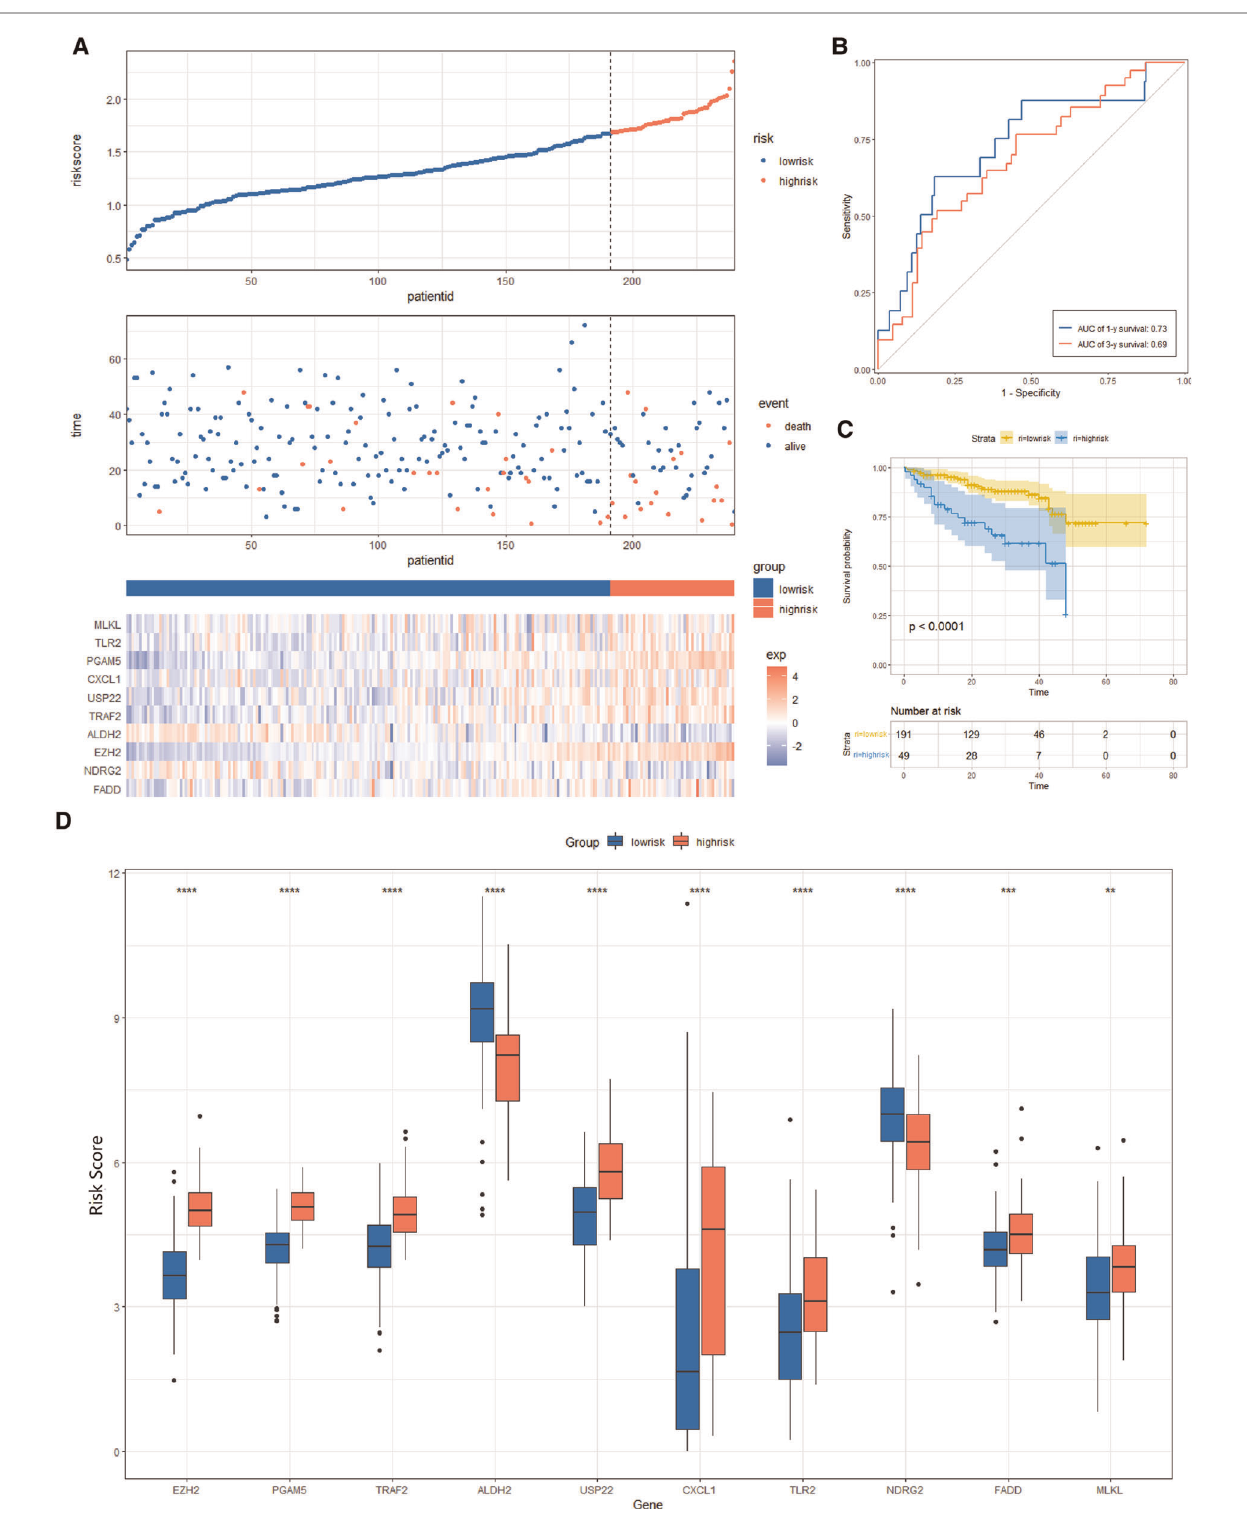
FIGURE 9 | Risk score analysis, prognostic performance, and survival analysis of the Risk Score Signature in the ICGC cohort. ( A ) Risk score and survival time distribution of patients as well as gene expression of necroptosis-related genes in Risk Score Signature. ( B and C ) Signature ’ s overall survival and ROC curves. ( D ) Expression of key molecules in the low- and high-risk